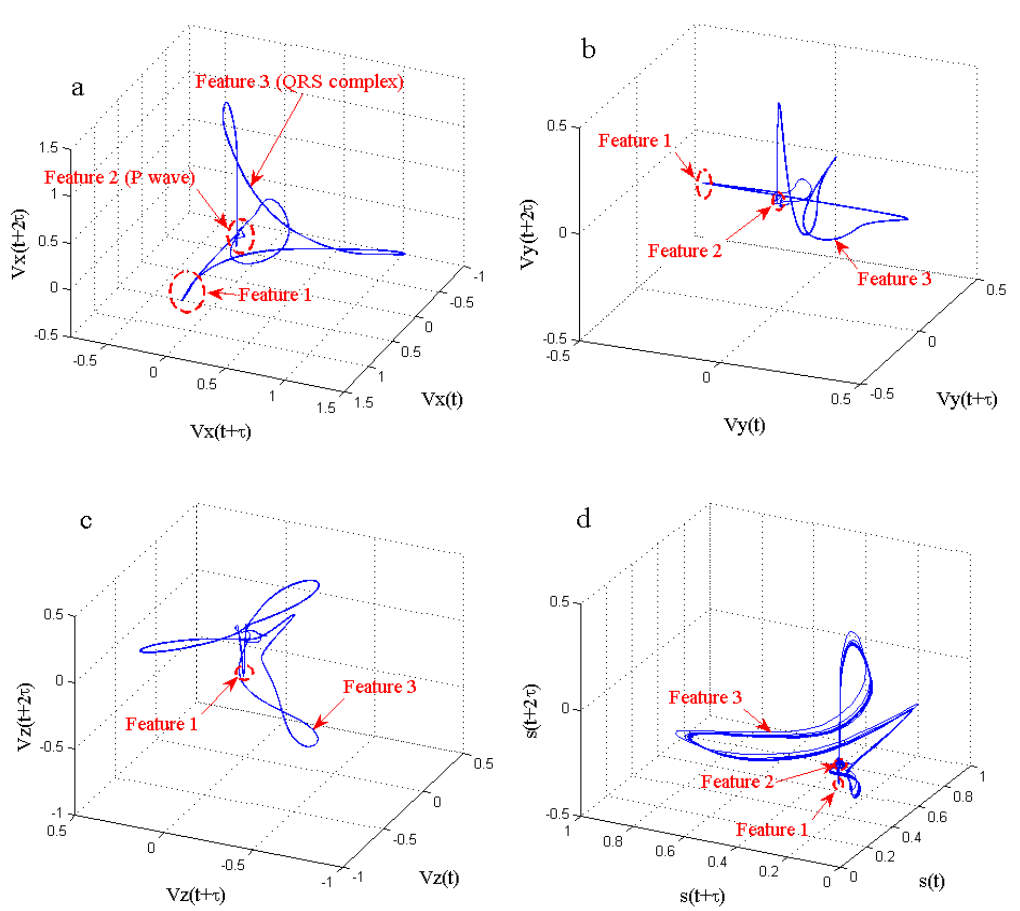
Figure 4. Reconstructed phase trajectories of synthetic ECG signals. ( a – c ) are reconstructed phase trajectories of V x , V y and V z , respectively. ( d ) Is reconstructed phase trajectory of final fused result via NDFA.